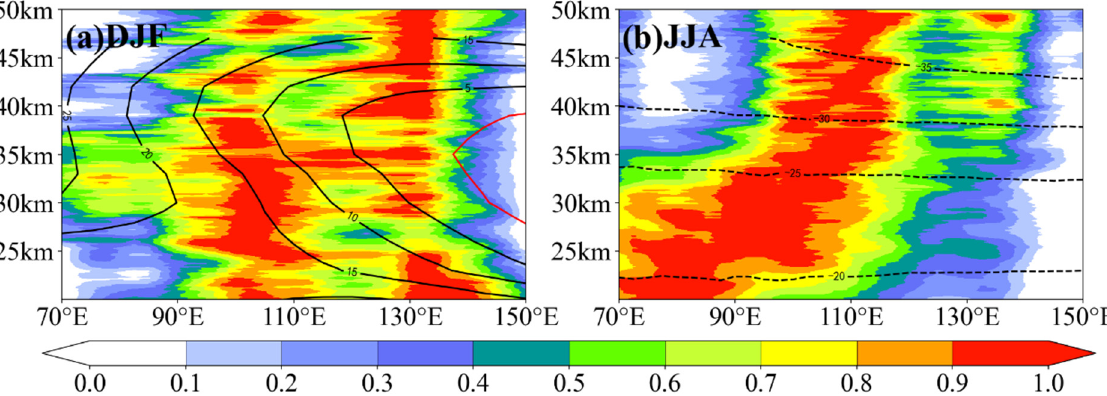
Figure 7. Longitude–height distribution of normalized Ep (shaded) and zonal westerly (solid lines, unit: m s − 1 ) and easterly (dashed lines, unit: m s − 1 ) winds along 40° N (±2.5°) ( a ) and 20° N (±5°) ( b ).